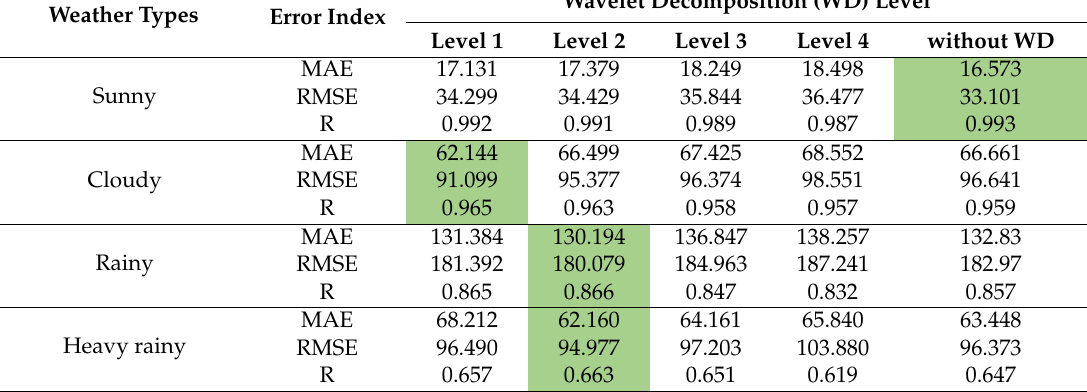
Table 6. The performance comparison of DWT-CNN-LSTM model at different WD levels using the dataset of Desert Rock